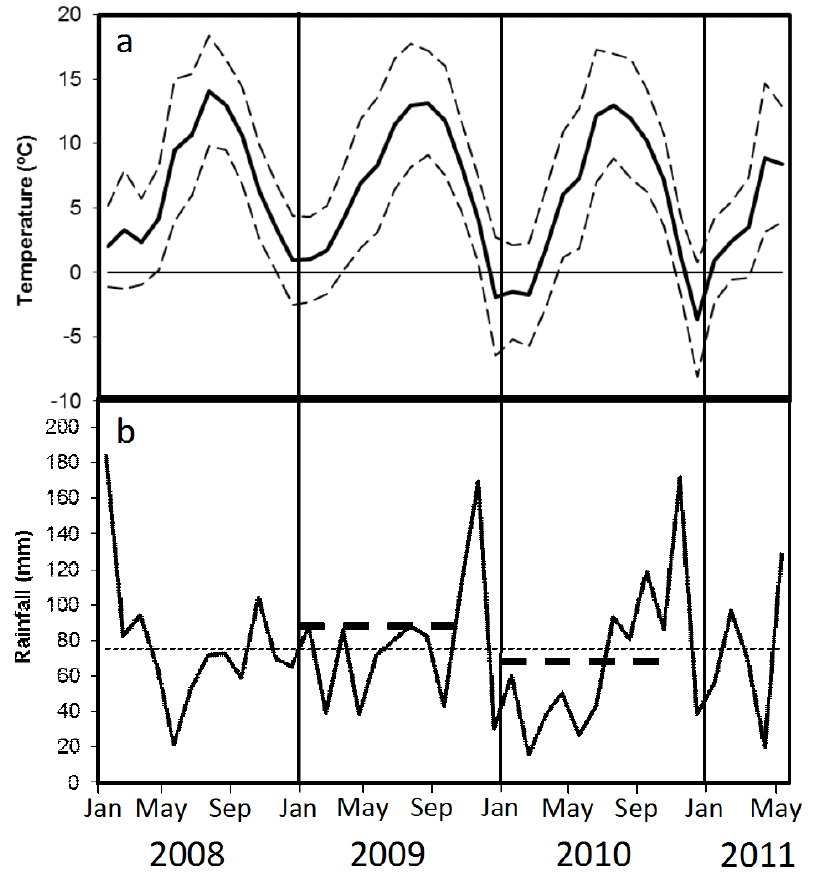
Figure 2. Braemar Meteorological Office weather data from January 2008 to May 2011. (a) Mean monthly air temperature (°C); dashed lines represent mean monthly minimum and maximum temperatures. (b) Mean monthly rainfall (mm); mean rainfall during the two study periods is indicated by bold dashed lines, and the mean monthly rainfall for 1981–2010 (75 mm) is indicated by the lighter dashed